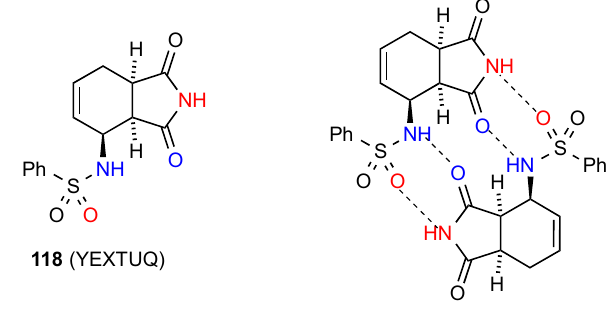
Figure 43. Structure adopted by compound 118.